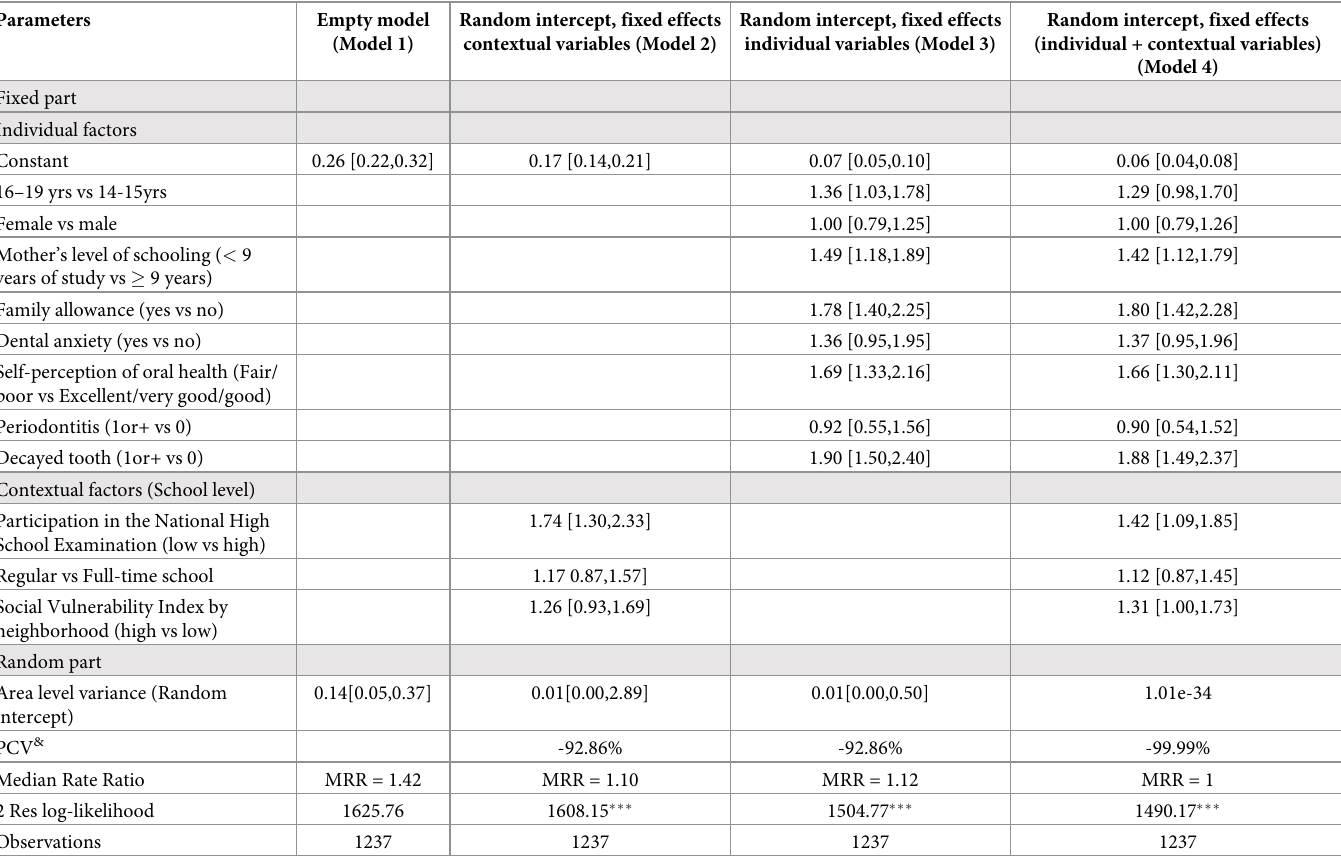
Table 2. Multilevel adjustment including Social Vulnerability